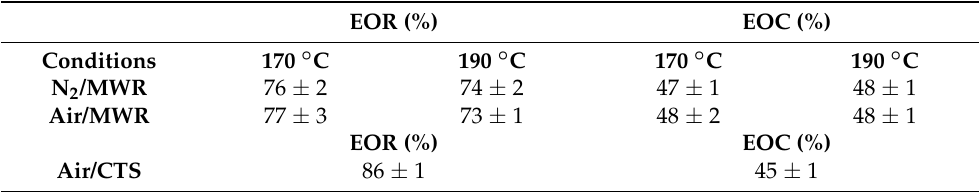
Table 2. Summary of some quantitative parameters from the FTIR spectra, such as EOR and EOC, taking into account the intensity of the band centered around 3340, 2200, and 1650 cm − 1 . EOR = [I 1650 /(I 1650 + I 2200 )] × 100 and EOC = [I 1650 /(I 1650 + I 3340 )] × 100. EOR (%) EOC (%) Conditions 170 ◦ C 190 ◦ C 170 ◦ C N 2 /MWR Air/MWR EOR (%) Air/CTS 86 ±